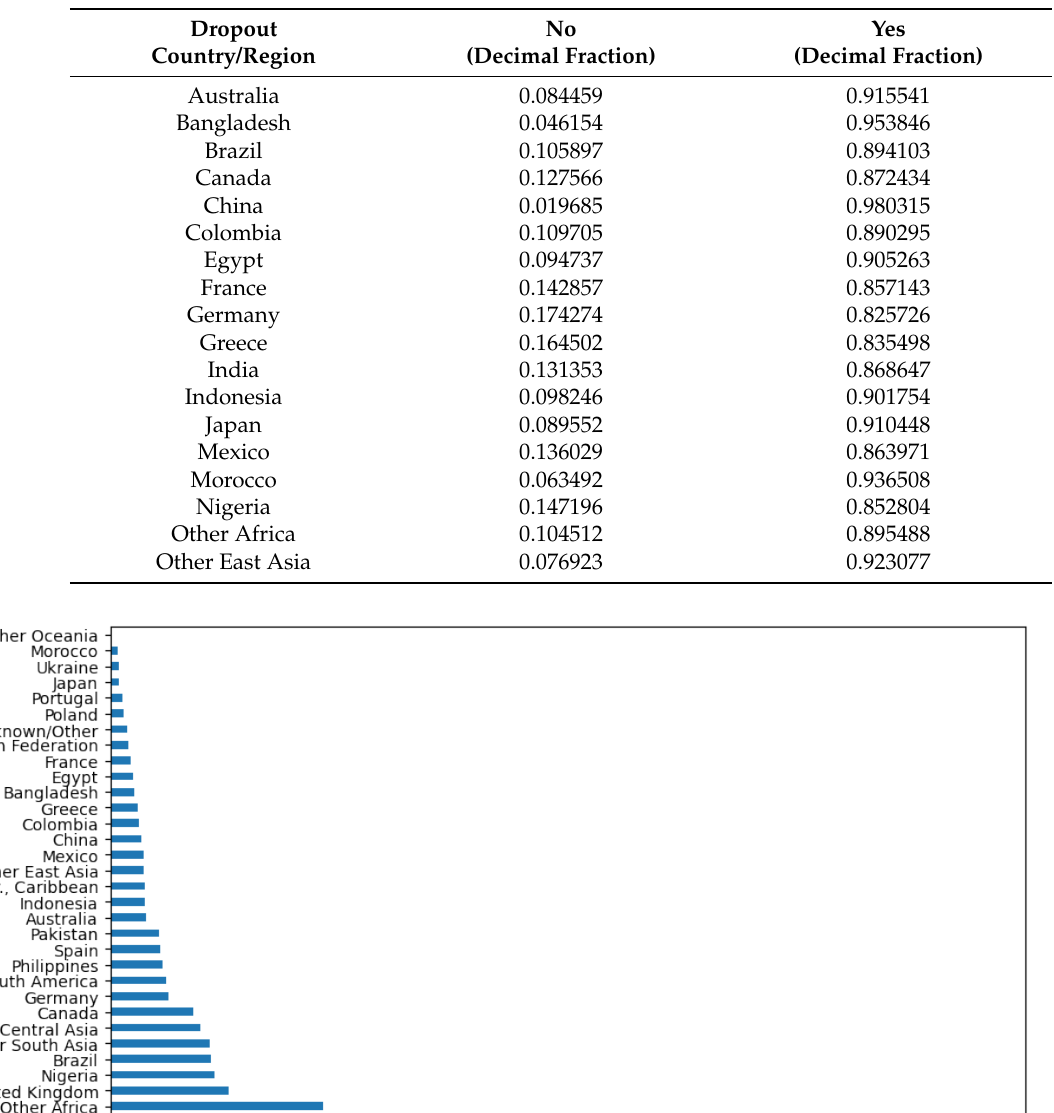
Table 5. Dropout rates of students in different countries